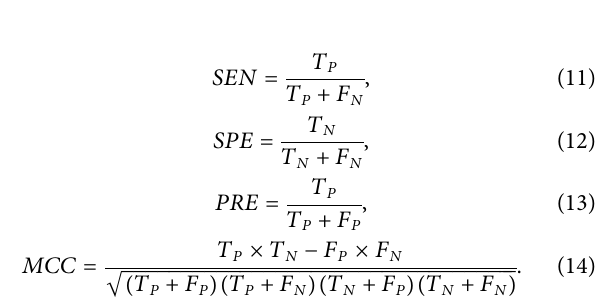
FIGURE 2 | Normalization of network topological features for binding site and non-binding site. “ × ” is average value; C is closeness; B is betweenness; EC is eigenvector centrality; D is degree; CC is clustering coef fi cient; E is eccentricity; and AN is average nearest neighbor degree.